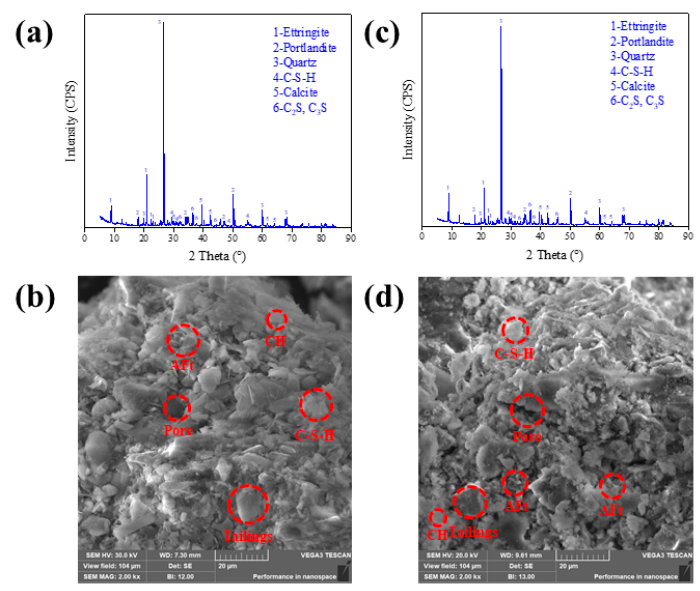
Figure 8. XRD patterns and SEM images of CTB with CTR of 1:12 at curing time of 3 days: ( a , b ) 20 ◦ C, ( c , d ) − 20 ◦ C.